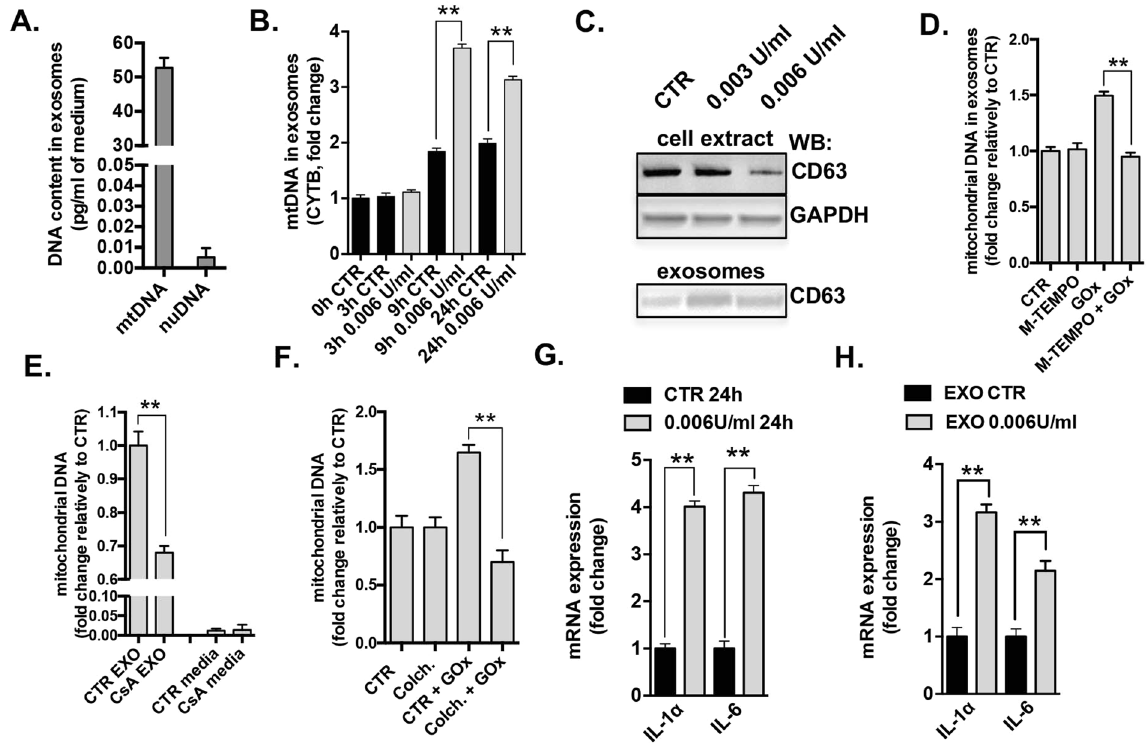
Figure 4. Oxidatively stressed cells induce release of damaged mtDNA via exosomes. ( A ) Comparison of mitochondrial and nuclear DNA in exosomal fraction isolated at 24 h from BEAS 2B cells treated with 0.006 U/ ml GOx. ( B ) Time-dependent release of the mtDNA from control and BEAS 2B cells treated with 0.006 U/ml of GOx. ( C ) Protein level of CD63, marker of exosomes, in BEAS 2B cell extract and in exosomal fraction. MtDNA release from cells pretreated for 1 h with ( D ) 300 nM of Mito-TEMPO; ( E ) 3 μ M cyclosporine-A or ( F ) 3 μ M colchicine in control and 0.006 U/ml of GOx-treated BEAS 2B cells. Data represent average ± SEM of n = 5 biological replicates. Representative images of n = 3 independent experiments are shown. ** p < 0.01 vs .